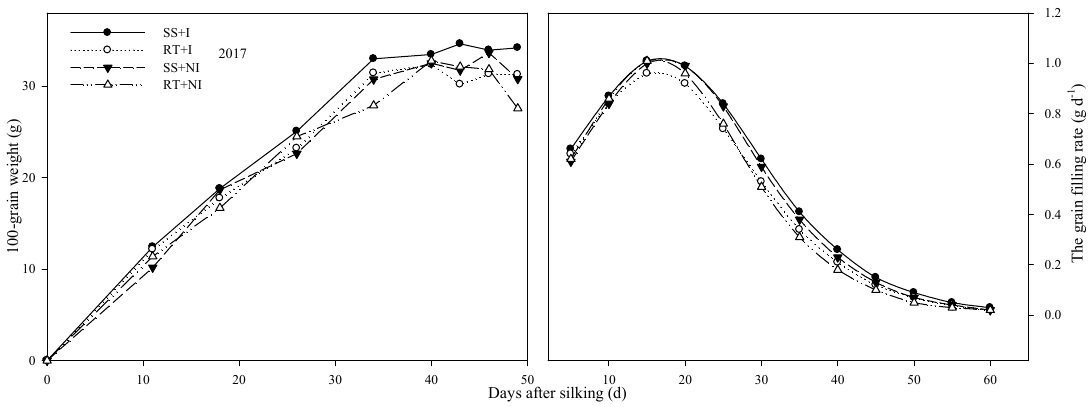
Figure 5. E ff ects of di ff erent tillage methods on grain weight accumulation and grain-filling rate. Figure 5. Effects of different tillage methods on grain weight accumulation and grain-filling rate. Table 7. E ff ects of di ff erent tillage methods on grain-filling characteristic parameters.